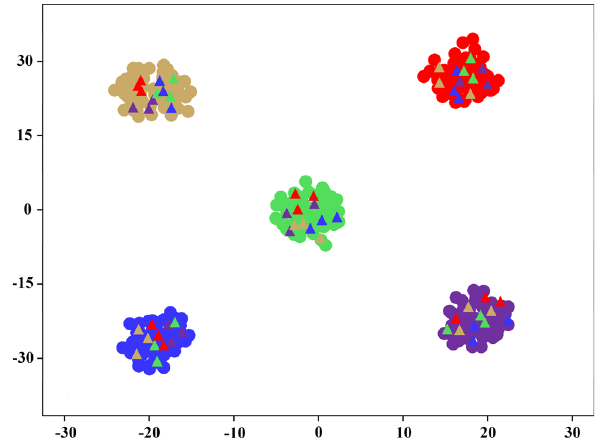
Fig. 4 A t-SNE figure to visualize x-vectors of source utterances and adversarial examples. Source voices are denoted by circles with five different colors with each color for one speaker. Adversarial examples are denoted by triangles with five different colors where the color indi- cates the source speaker of an adversarial example (Better viewed in